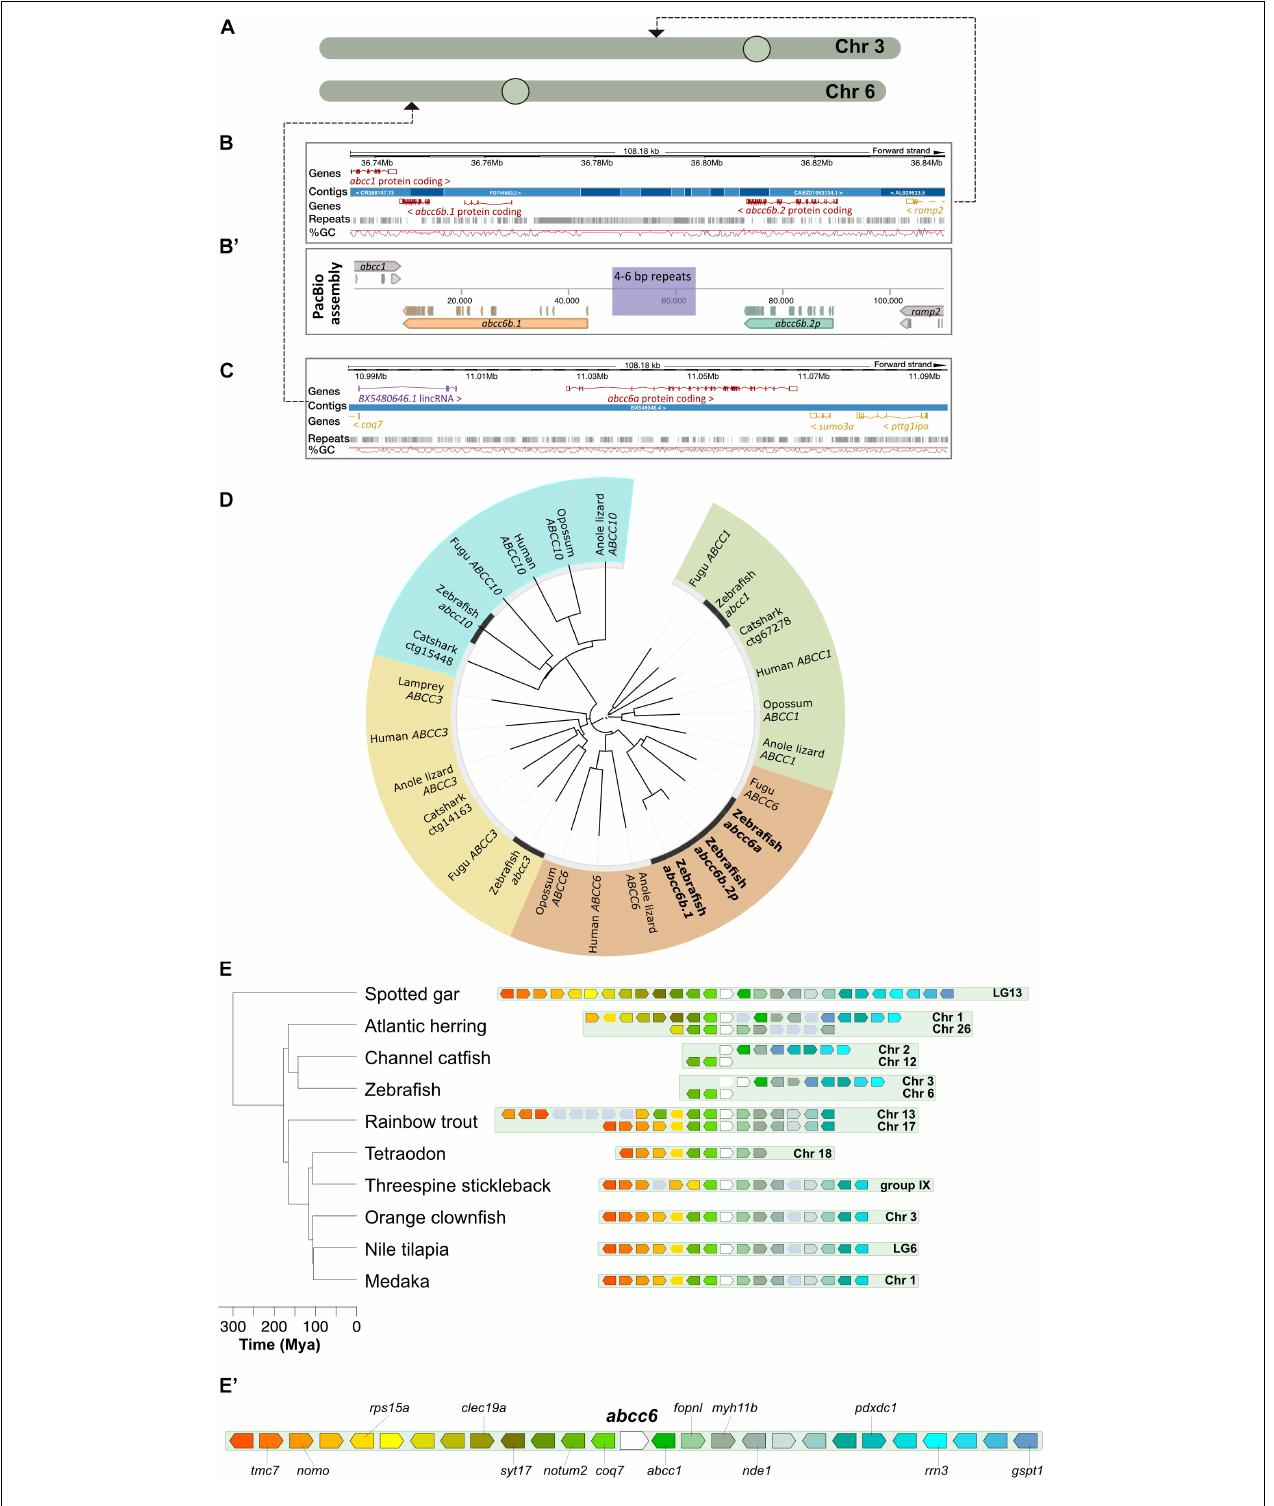
FIGURE 1 | Annotation and phylogenetic relationships of the zebrafish ABCC6 orthologs. (A) Chromosomal positions of zebrafish ABCC6 orthologs. (B,B’) Ensembl (GRCz11) assembly of the respective chromosomal 3 regions with abcc6b.1 and abcc6b.2p and reassembly of this genomic region using PacBio reads. Note the abundance of repeats in the interval between abcc6b.1 and abcc6b.2p coinciding with the highly fragmented Ensembl assembly. (C) Ensembl (GRCz11) assembly of the abcc6a containing chromosomal six region. (D) Phylogenetic analysis of zebrafish ABCC1, ABCC3, ABCC6 , and ABCC10 paralogs. (E,E’) Syntenic analysis of the abcc6 genomic region in different teleost species using the spotted gar genome as reference (see text for details).